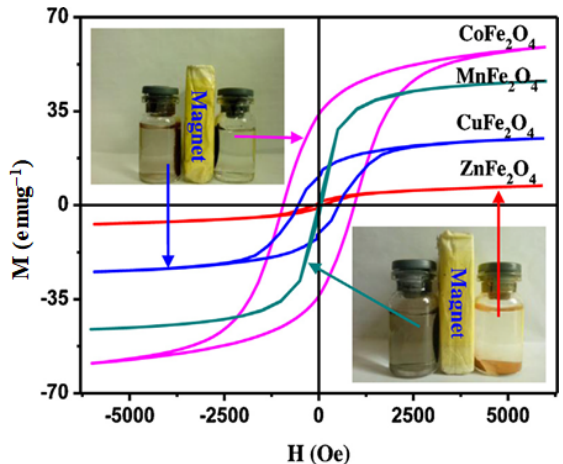
Figure 2. Magnetic properties behavior of different photocatalysts at room temperature [67]. Repub- lished with permission from